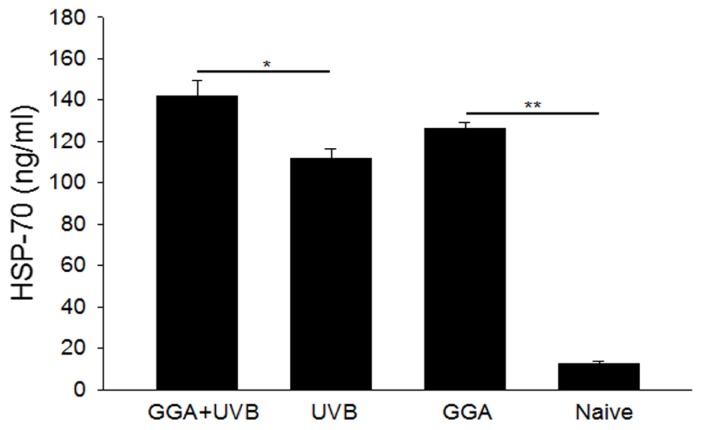
Enzyme-linked immunosorbent assay (ELISA) evaluation of HSP70 expression after treatment with geranylgeranylacetone and ultraviolet B exposure. Data are shown as mean ± SEM (n = 4), **p < 0.01; *p < 0.05 (Mann-Whitney U-Test).